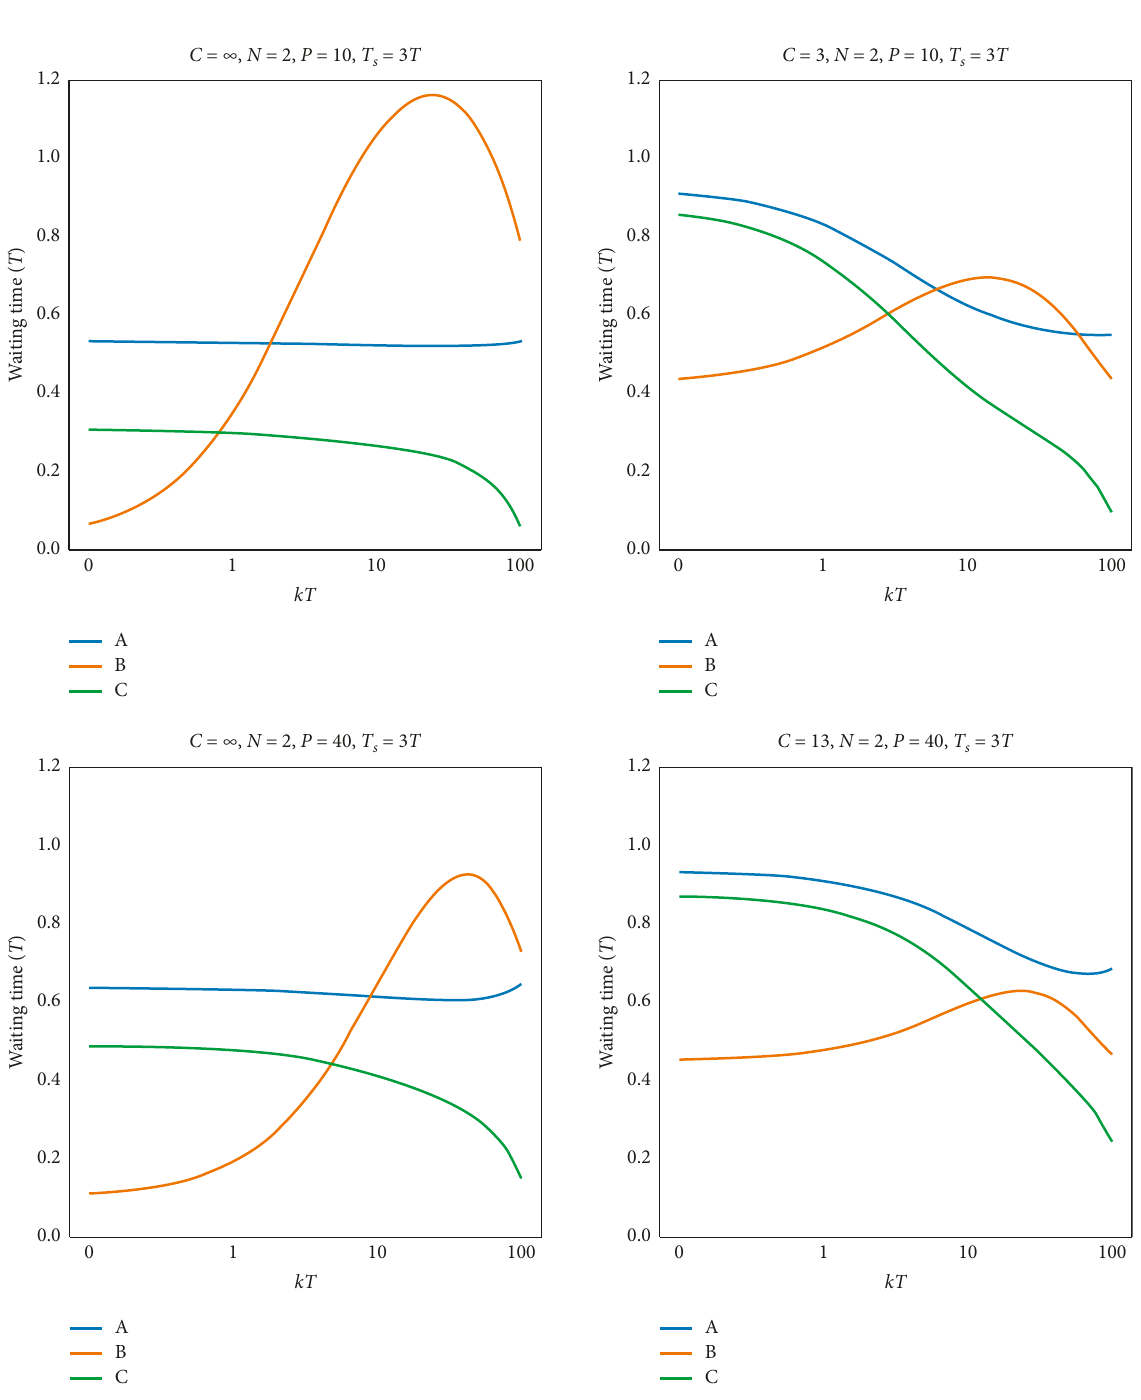
Figure 2: Average waiting time for two buses in the three configurations A, B,C described in Sections 2 and 3. The two upper plots represent a case of low demand P from the spike bus stop while the two lower plots represent high demand P . The plots on the left assume unlimited capacity of the buses, and the plots on the right explicitly limit the capacity of buses at c � ⌊ P /3 ⌋ while boarding passengers from the spike bus stop . As discussed in Section 4, synchronised bunched buses (configuration B) outperform perfectly staggered buses (configuration C) when the demand of the spike bus stop is high as compared with the regular bus stop . Limiting capacity further increases the advantage of bunched buses. For this example, T is set to a value of 100 time units and T s � 3 T